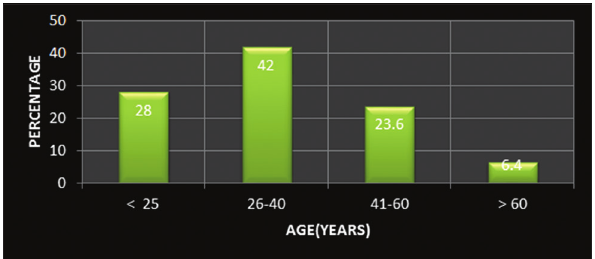
Figure-1: Distribution of respondents according to